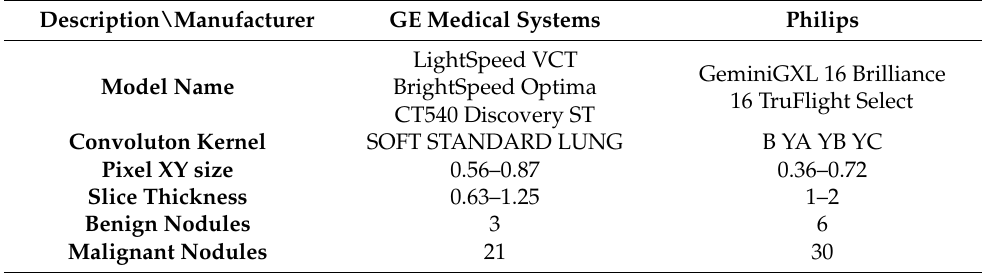
Table 1. Details of the acquisition parameters by scanner